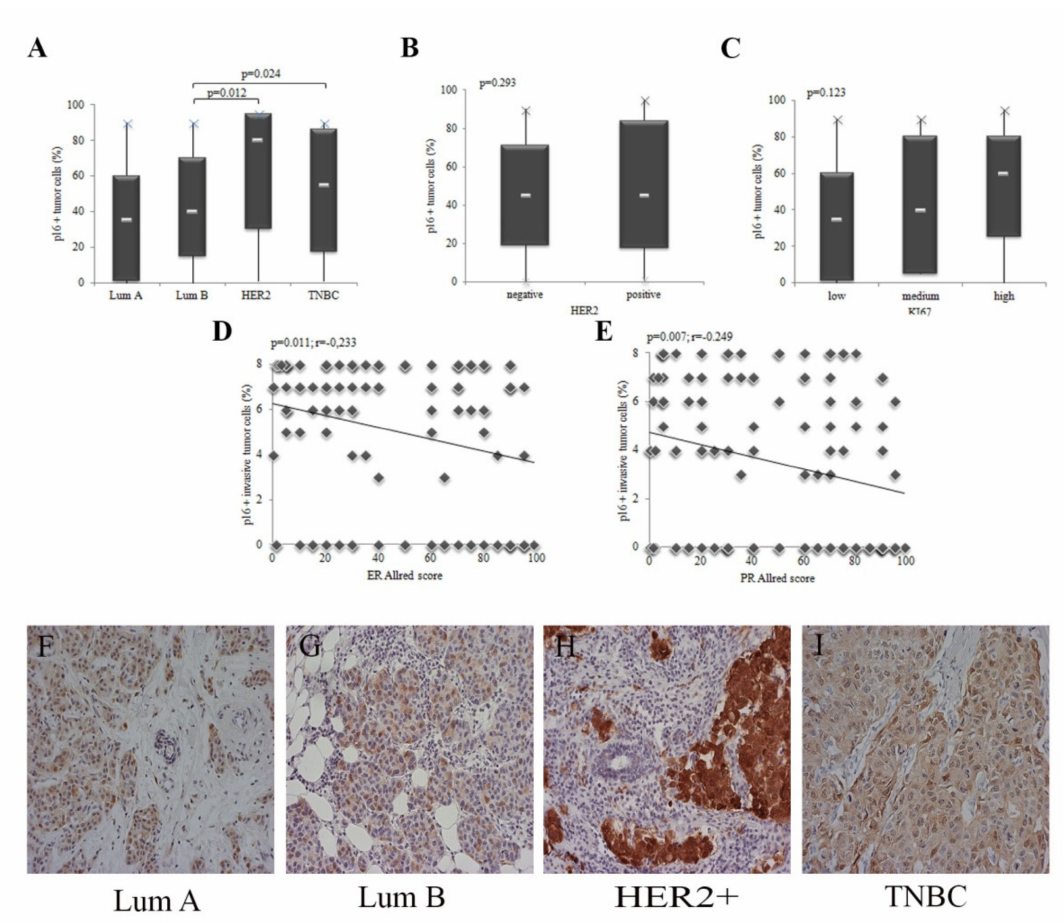
Figure 2. Expression of p16 in different molecular subtypes of breast cancer. All IBCs are divided into four molecular subtypes. IHC expression of p16 was quantified in the nucleus and cytoplasm of tumor cells and presented as a percentage of positive in relation to the total number of evaluated cells. ( A ) HER2+ subtype IBC showed the highest expression of p16. The result is shown as the median. Statistical significance was analyzed using the Kruskal–Wallis and Mann–Whitney tests ( p = 0.025). ( B ) All IBCs were divided into negative and positive depending on HER2 status. There is no difference in p16 expression depending on HER2 expression. The result is shown as the median. Statistical significance was analyzed using the Mann–Whitney test ( p = 0.293). ( C ) Ki67 expression is categorized into 3 groups: low (Ki67 < 15%), medium (Ki67: 16–30%) and high (Ki67 > 30%). The expression of p16 in tumor cells does not depend on the expression of Ki67. The result is shown as the median. Statistical significance was analyzed using the Kruskal–Wallis and Mann–Whitney tests ( p = 0.123). ( D,E ) The ER and PR expression was analyzed through the Allred score. The increase in p16 expression in tumor cells was accompanied by significantly reduced ER and PR expression. Statistical significance was analyzed using by Spearman correlation coefficient ( p = 0.011; r = − 0.233; p = 0.007; r = − 0.249). IHC expression of p16 in molecular subtypes—( F ) Luminal A. ( G ) Luminal B. ( H ) HER2+. ( I ) TNBC (original magnification 200 ×